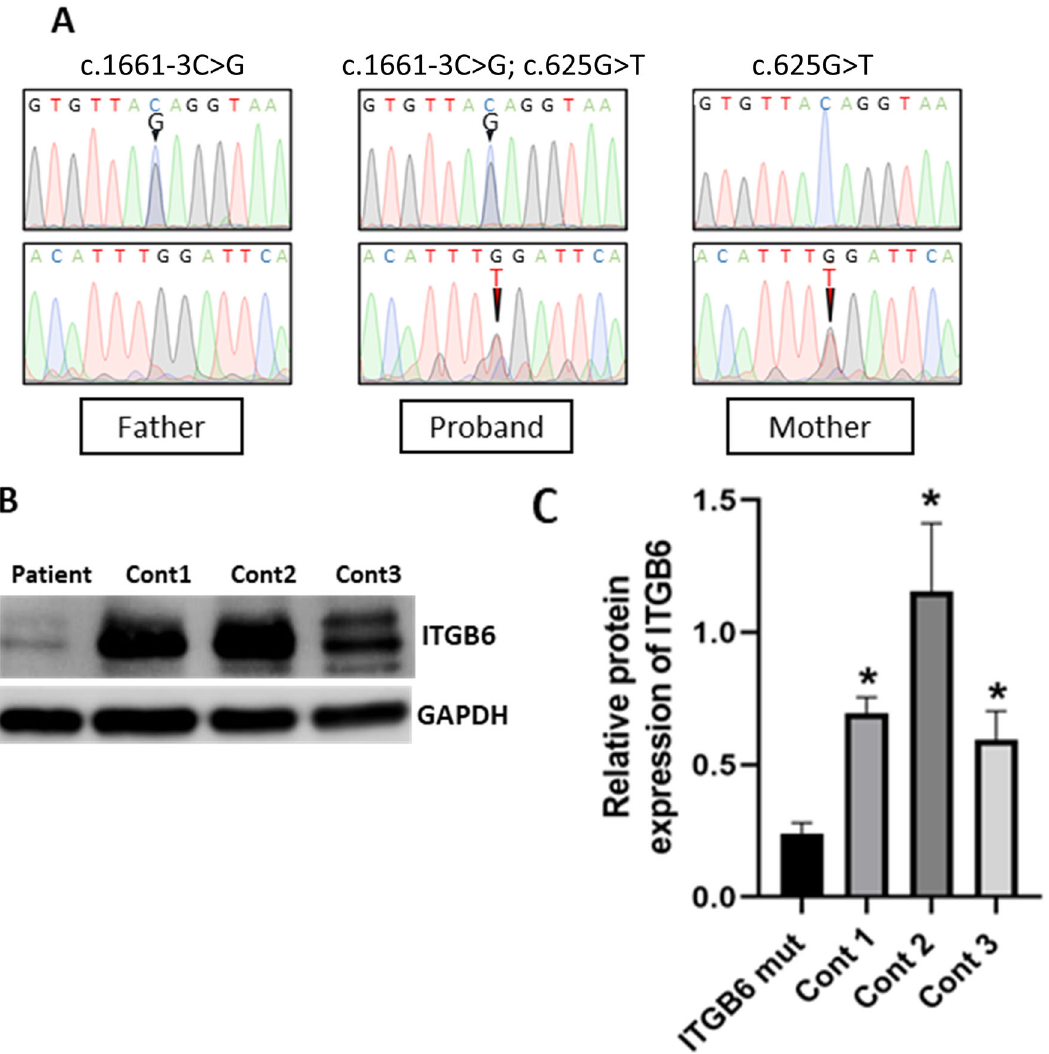
Fig. 2 Genetic analysis and protein expression. A Chromatogram demonstrated the compound heterozygous variants in the proband. The c.625 G > T, p.(Gly209*) was inherited from the mother and the c.1661-3 C > G from the father. B , C The ITGB6 level in the patient ’ s gingival cells was signi fi cantly lower than that in